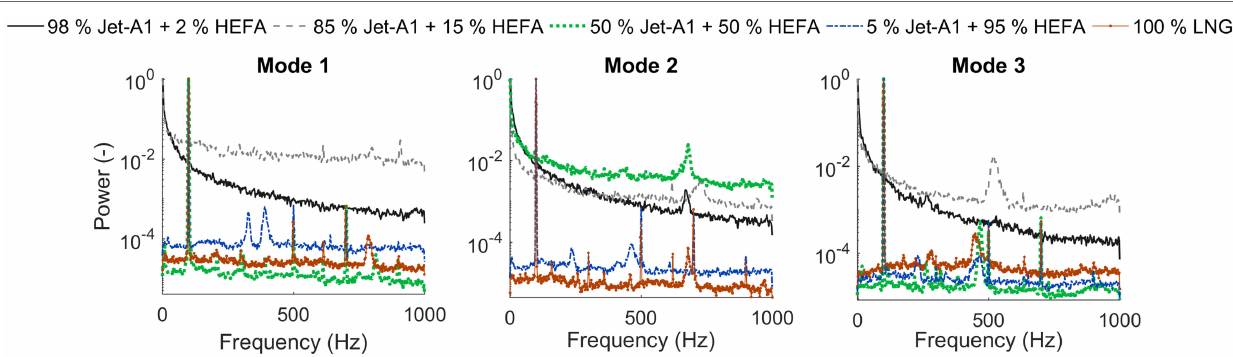
FIGURE 3 | Normalized power spectral density plots of engine vibration on five different fuel blends from the lowest (Mode 1) to the highest (Mode 3) air-to-fuel ratio.